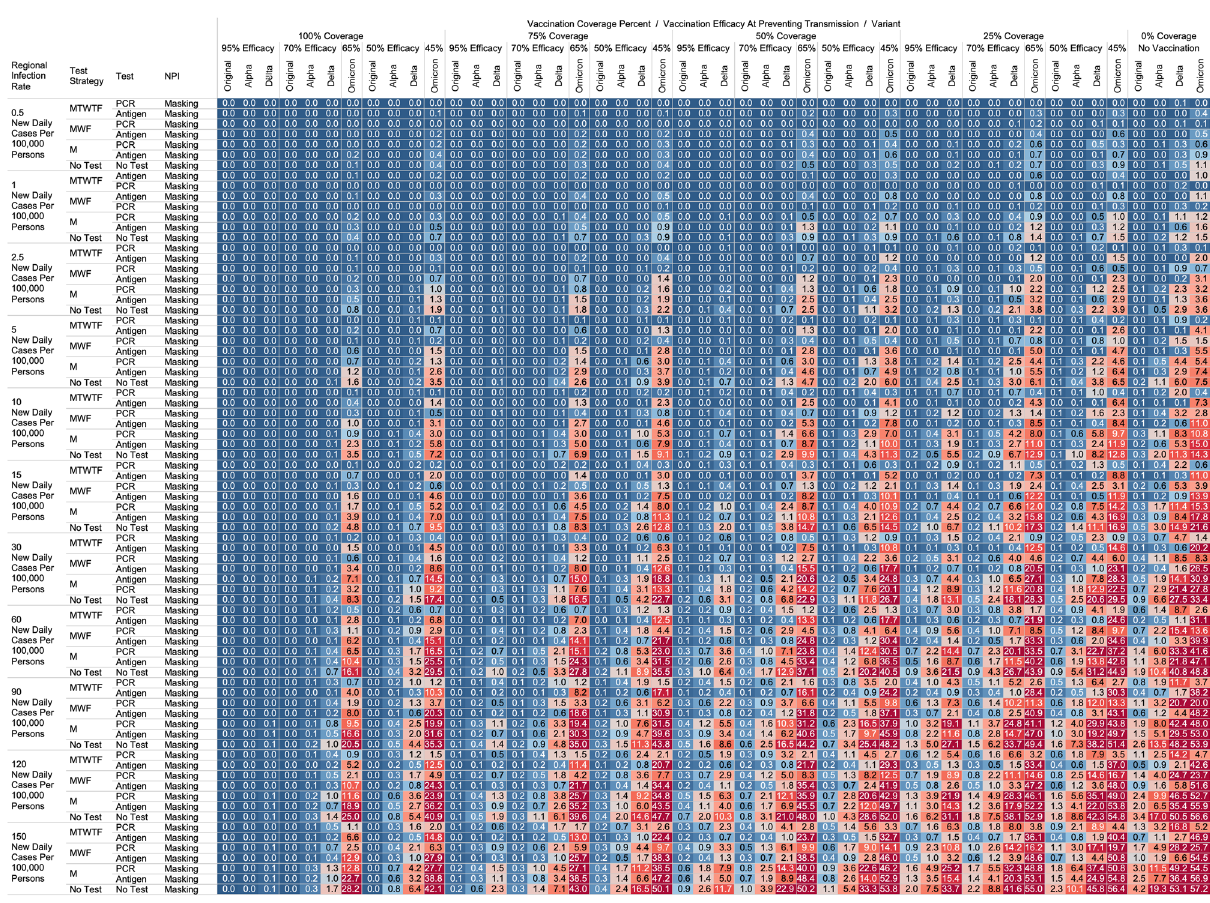
Figure 2. Heatmap of simulated workplace-acquired infections through 480 person weeks with testing performed in all workplace members with consistent mask wearing. The sensitivities of PCR and antigen tests a variant specific as outlined in Table